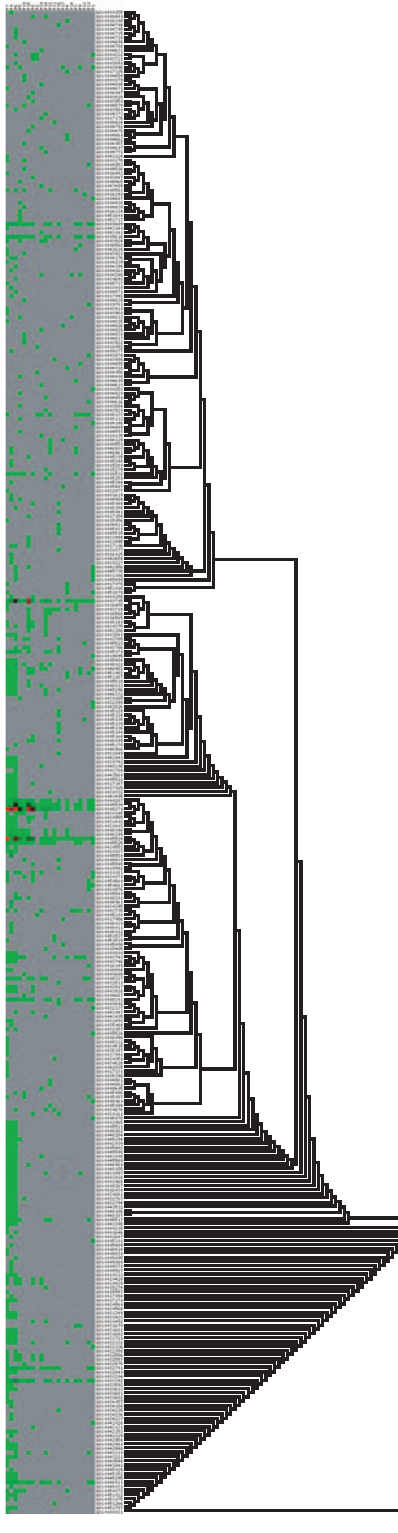
Figure 2. Representative annotation matrices for biological process. Grey cells in the matrix are not within the outlier of each category. The left part of the tree are generated from GO DAGs not based on the similarities of the rows of the matrix.